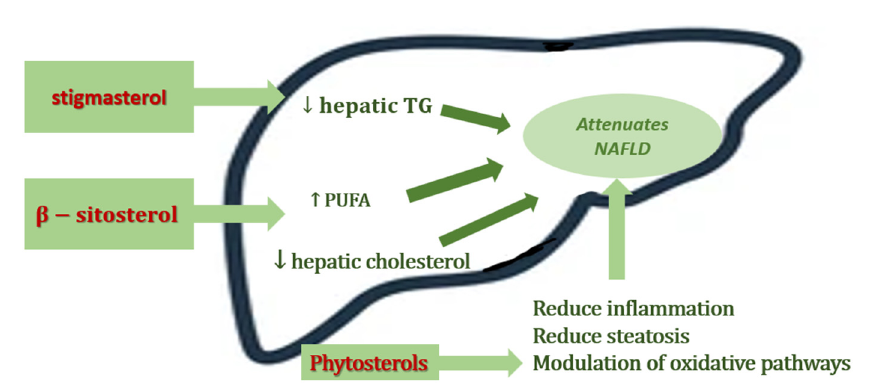
Figure 2. Beneficial effects of PSs in